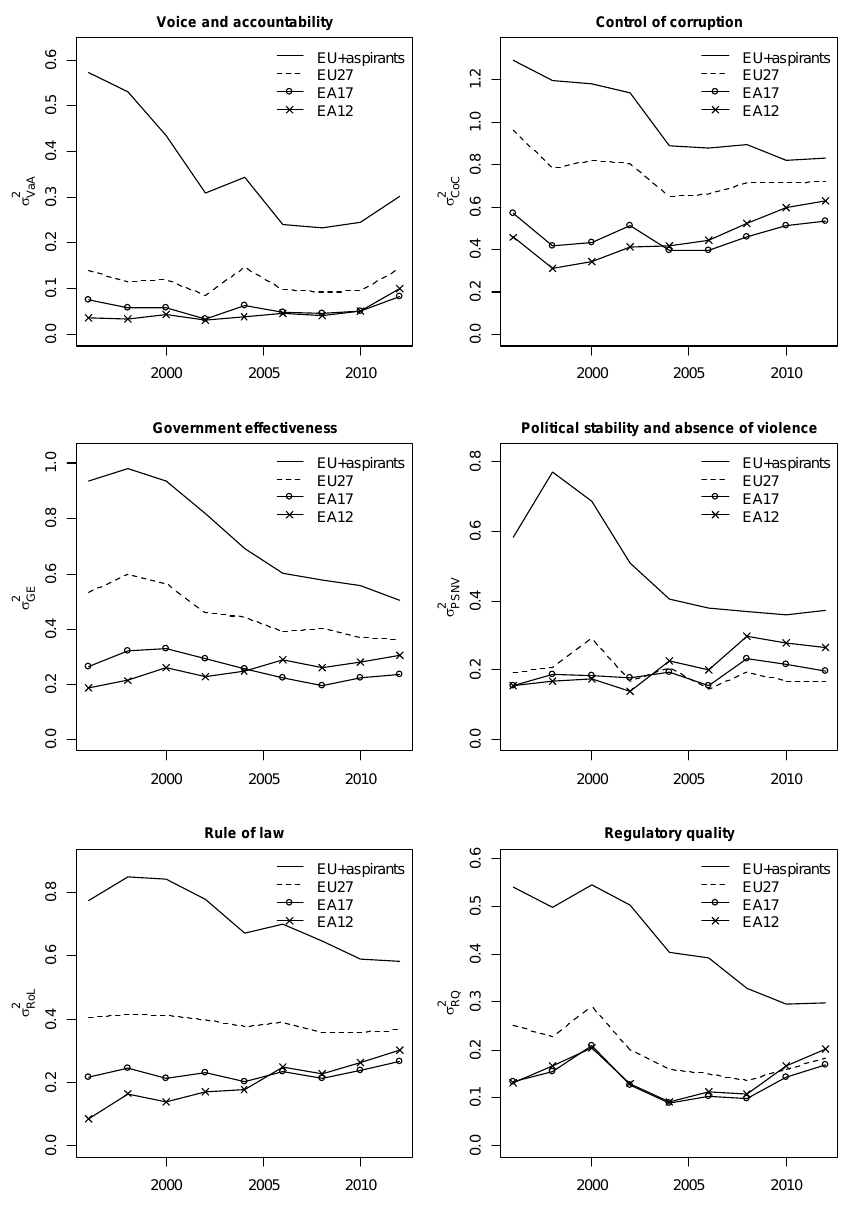
Figure 2 : WGIs’ σ -convergence in